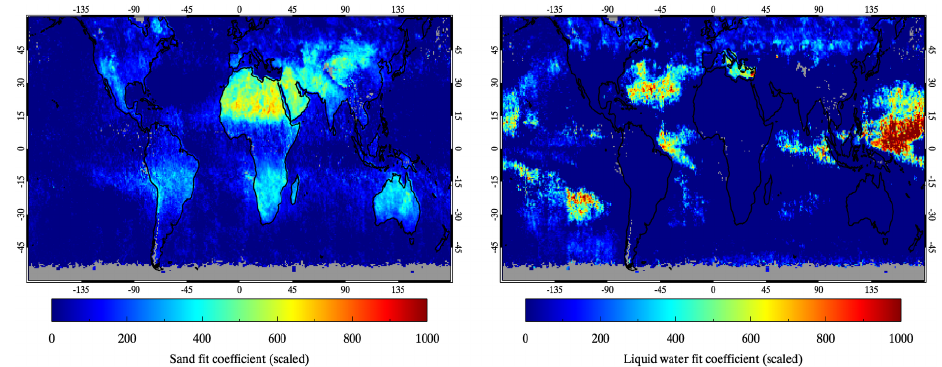
Figure 8. Average tropospheric sand (left) and liquid H 2 O (right) fit coefficient retrieved using Earth radiance reference DOAS during June 2005. Note that only positive SCDs have been plotted, and have been scaled to arbitrary values.